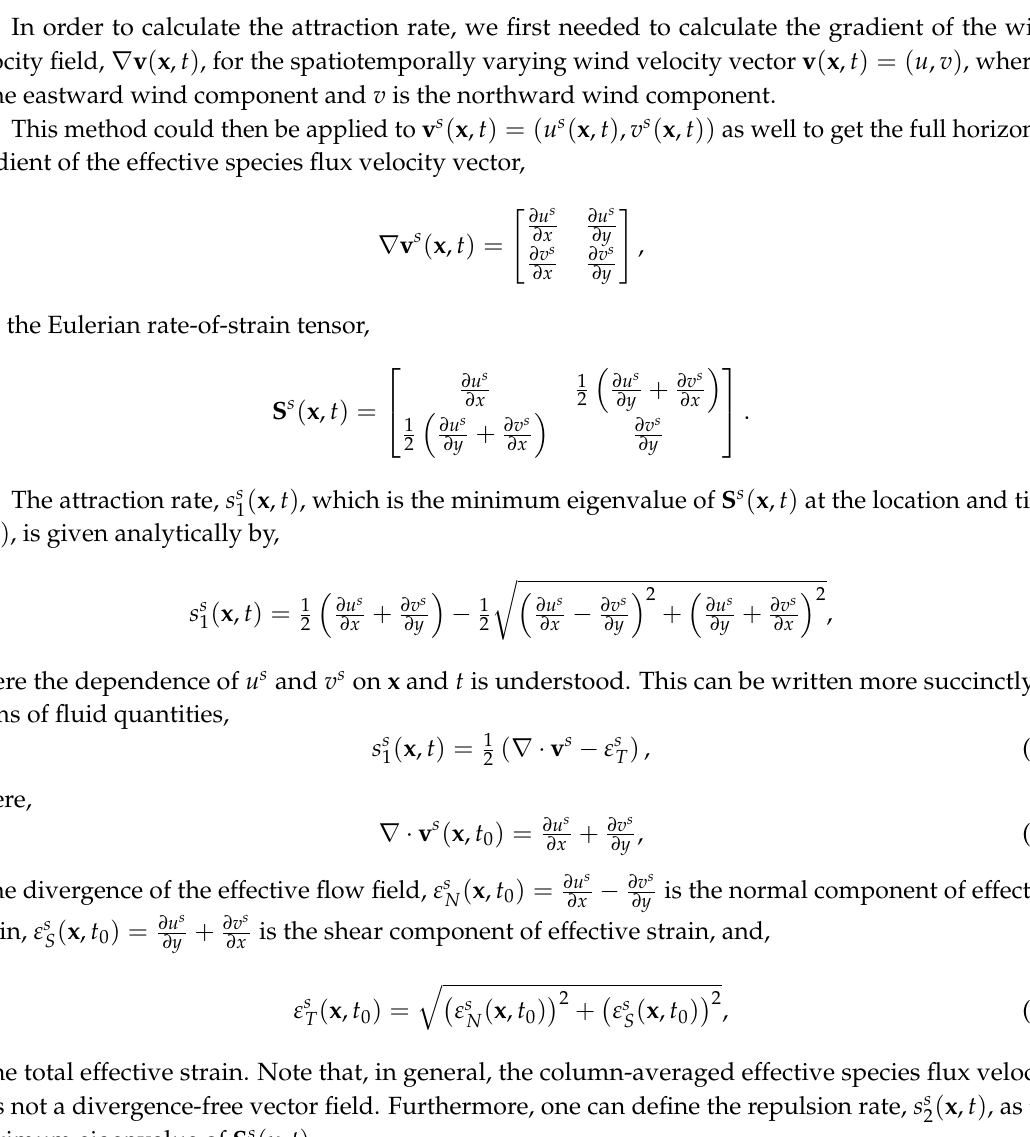
is the flow map for species s , as defined in [ t 0 , t ]